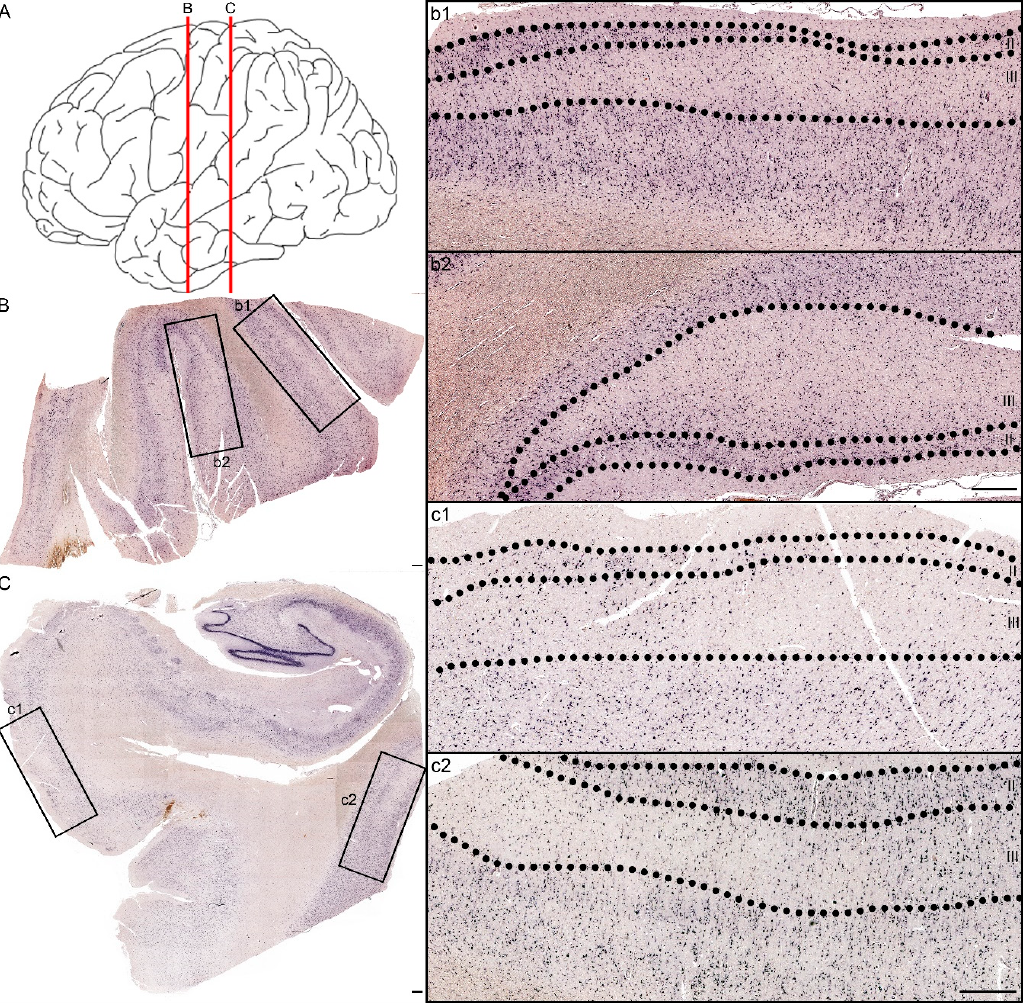
Figure 4. Patchy loss of miR-124-3p expression in the temporal cortex of a patient with severe TBI 5 days earlier. ( A ) Red lines indicate the coronal levels of sections illustrated in panels B,C. ( B ) miR-124-3p in situ hybridization from a section of the lateral temporal cortex. Note the neuronal loss in higher magnification images, particularly in layer III (b1, b2 correspond to boxed areas in panel B). ( C )